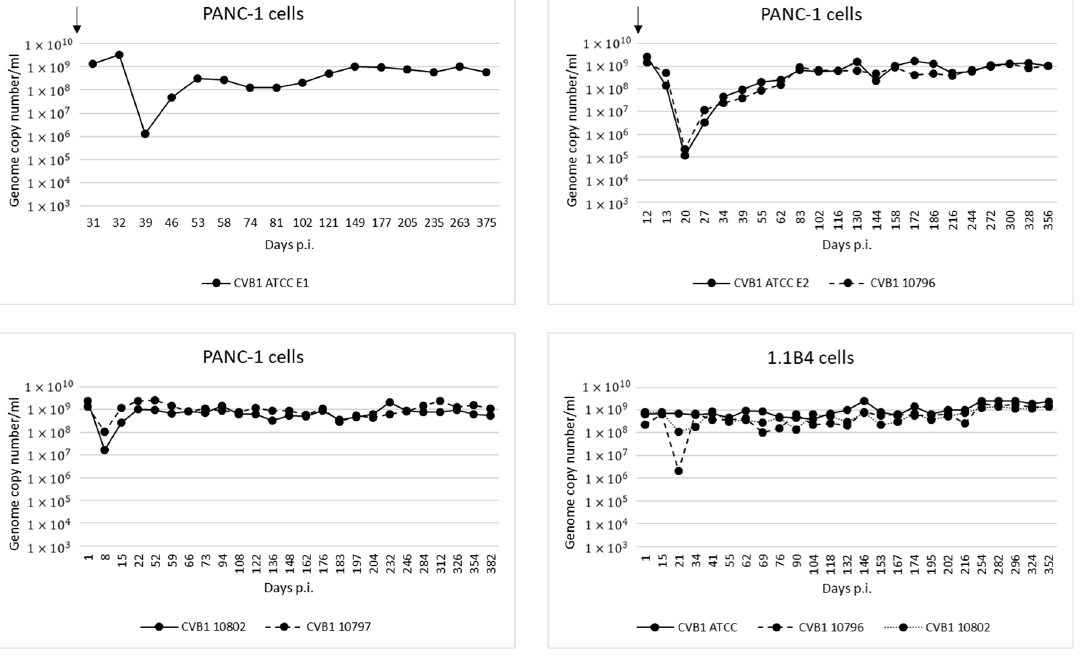
Figure 1. Genome copy numbers measured by RT-qPCR from cell culture supernatants collected from persistent infection models over time. In all the models the copy number eventually stabilized to approximately 10 8 to 10 9 copies/mL. Addition of fresh cells into three of the models is indicated by an arrow.